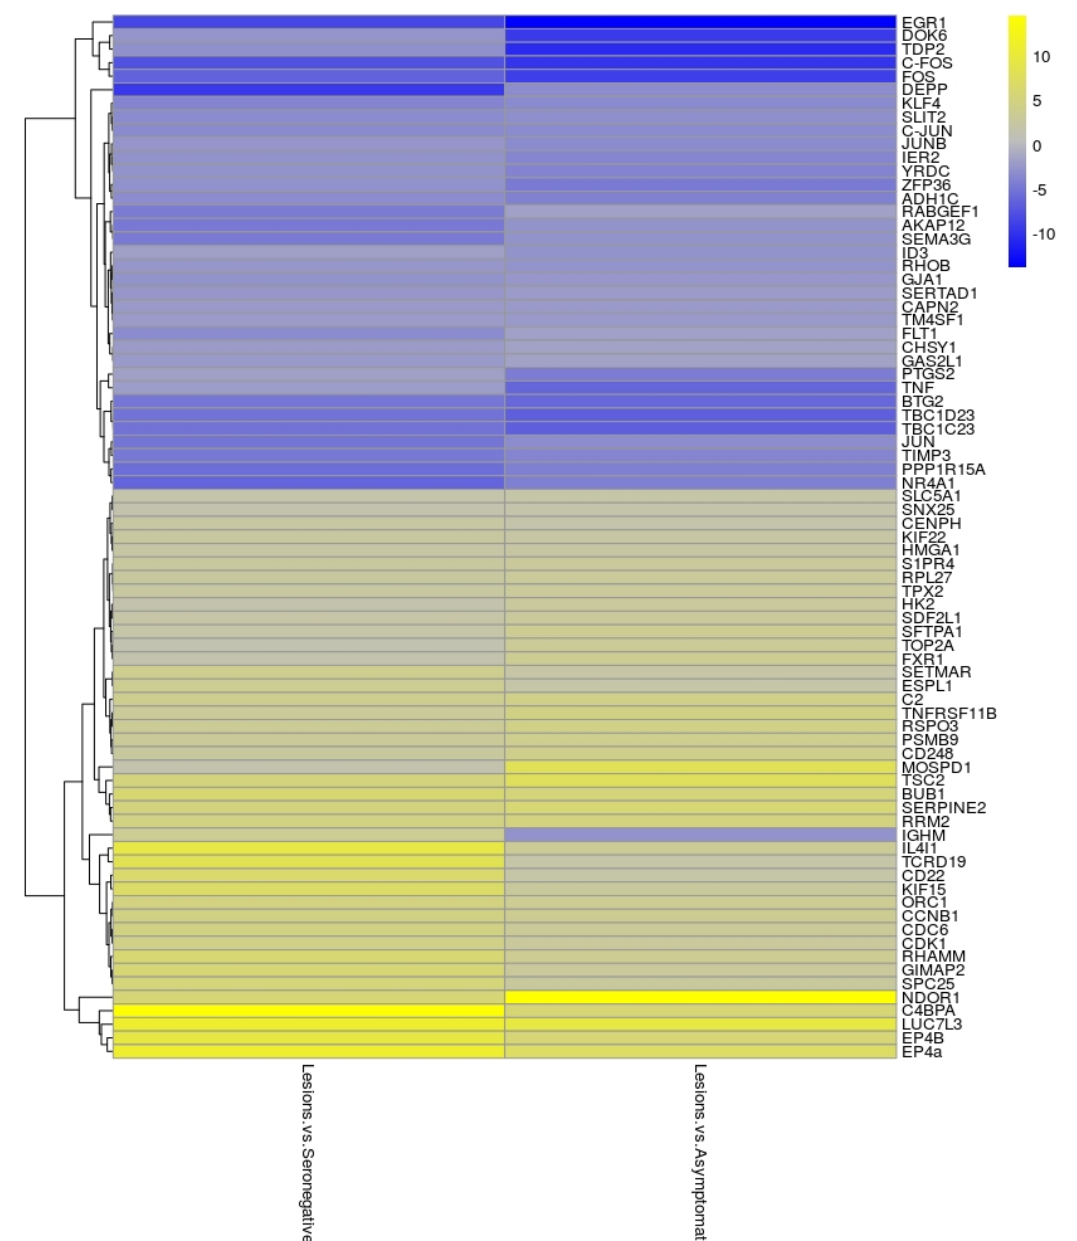
Figure 1. Heat-map of the most significant up- and down-regulated genes in the Lesions group relative to the Seronegative or Asymptomatic group. A blue color indicates genes’ down-regulation while a yellow color indicates genes’ up-regulation. The color intensity from blue to yellow indicates the gene expression levels.